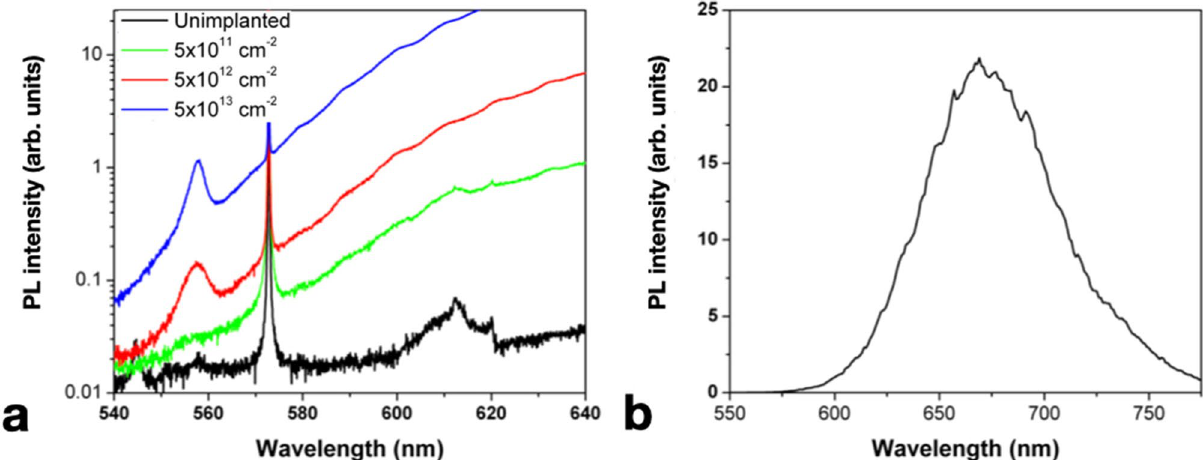
Figure 2. ( a ) Inset of Fig. 1a in the 540–660 nm spectral range. The axes are rescaled to highlight the PL emission peak at 558 nm. ( b ) PL spectrum acquired under 520 nm laser excitation from a sample region implanted with 1.47 MeV F 2+ ions at 1 × 10 13 cm −2